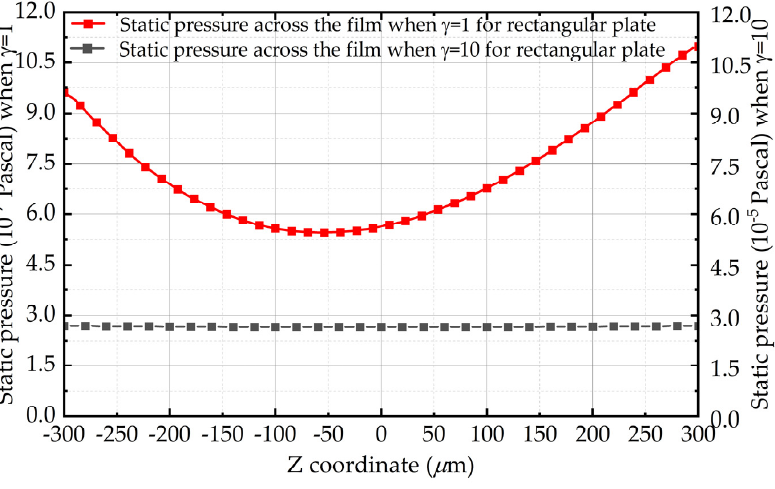
Figure 5. Pressure change across the fluid film with aspect ratio l/h for a rectangular plate when the air film thickness is 0.6 mm.